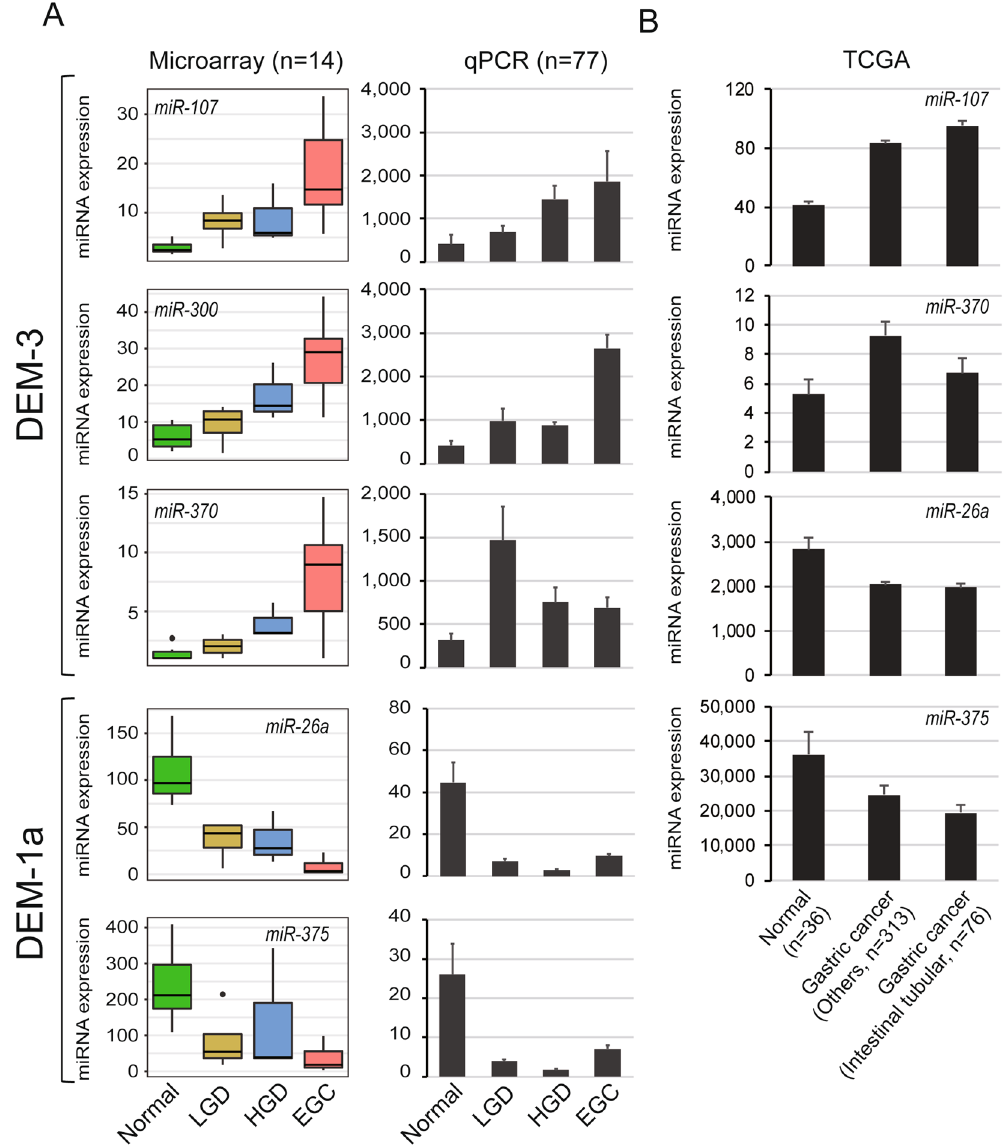
Figure 2. Stepwise changes in the expression of miRNAs during early gastric carcinogenesis. ( A ) The expression levels of five miRNAs were measured using miRNA array and real-time RT-PCR. ( B ) The expression patterns of four miRNAs were also identified in TCGA